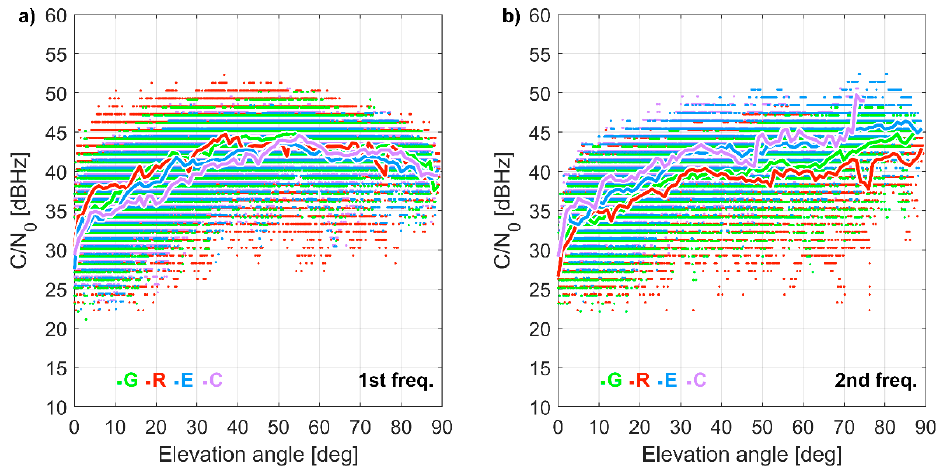
Figure 2. Carrier-to-noise ratio (C/N 0 ) for ( a ) 1st and ( b ) 2nd frequency as a function of satellite elevation angle for the u-blox receiver. The dots indicate individual measurements, while the lines represent the elevation mean. 22 September 2020 (24 h). G, R, E, C stand for GPS, GLONASS, Galileo, and BeiDou, respectively.